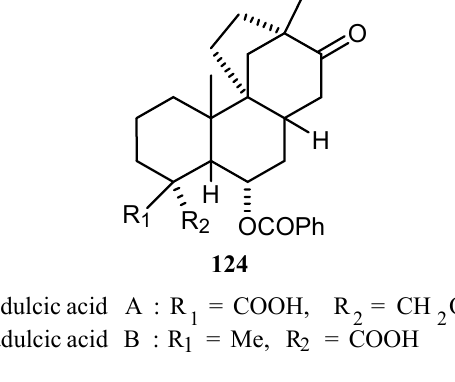
Figure 14. Scopadulcic acid.